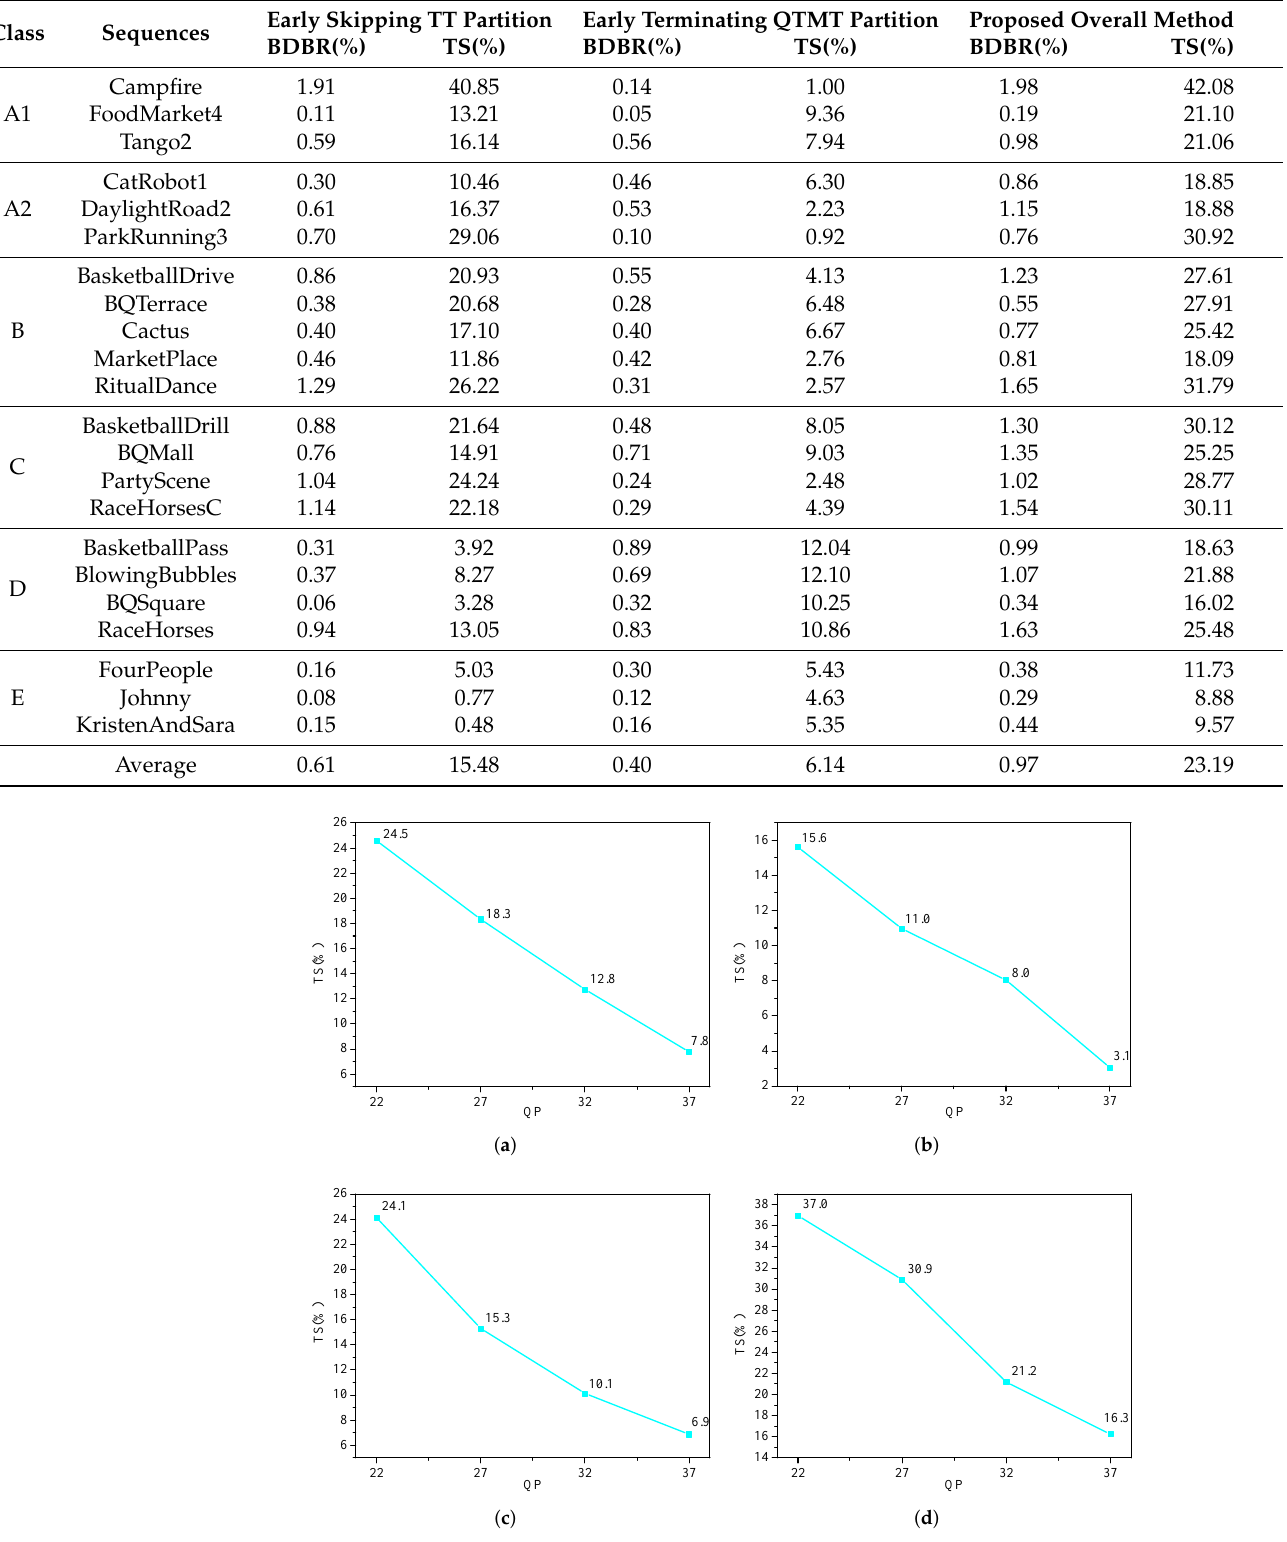
Table 7. Coding performance of proposed methods.